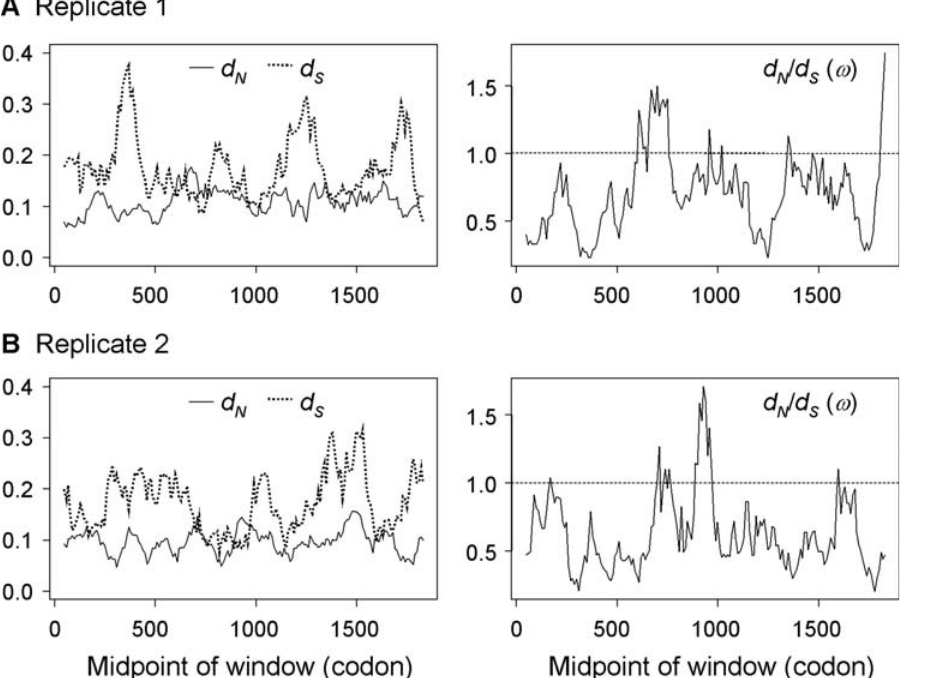
Figure 2. Sliding window plots of dˆ S , dˆ N and vˆ = dˆ N / dˆ S from two simulated data sets, generated under model M0 (one-ratio) using parameter estimates obtained from the comparison of the mouse and rat BRCA1 genes. The window size is 100 codons, and the offset between windows is one codon.